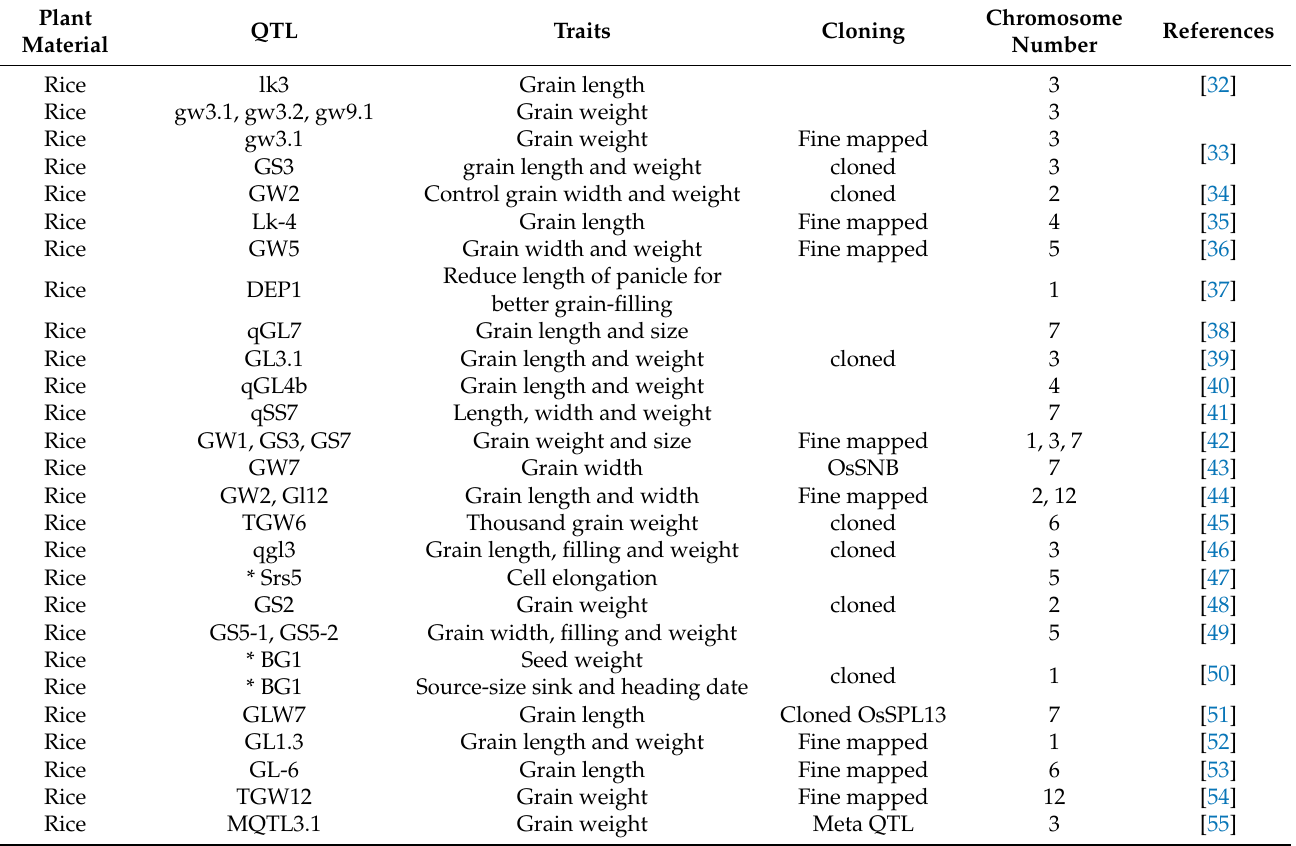
Figure 1. Rice grain diversity in size (thickness) and shape (length, width and length-to-width ratio). Source: [31]. Table 2. Quantitative traits loci of rice grain size and shape.